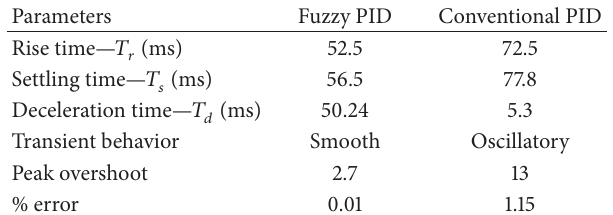
Table 3: Results of PID controller based control actuation system.